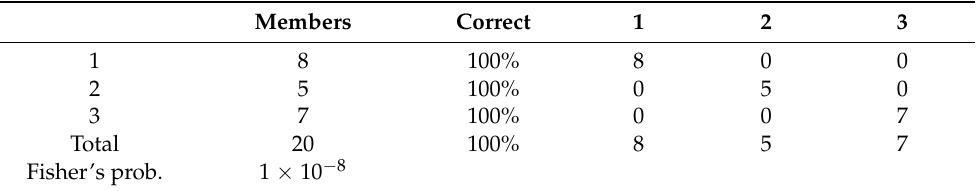
Total Fisher’s prob. 1 × 10 −